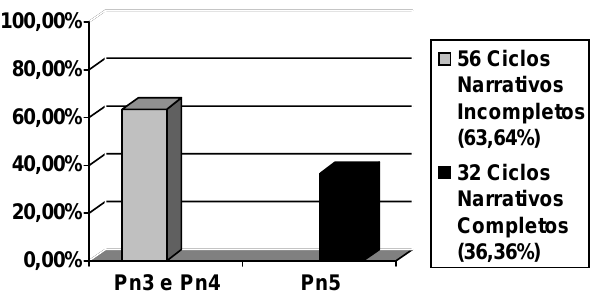
Figura 1. Percentagens de acordo com a evolução do ciclo